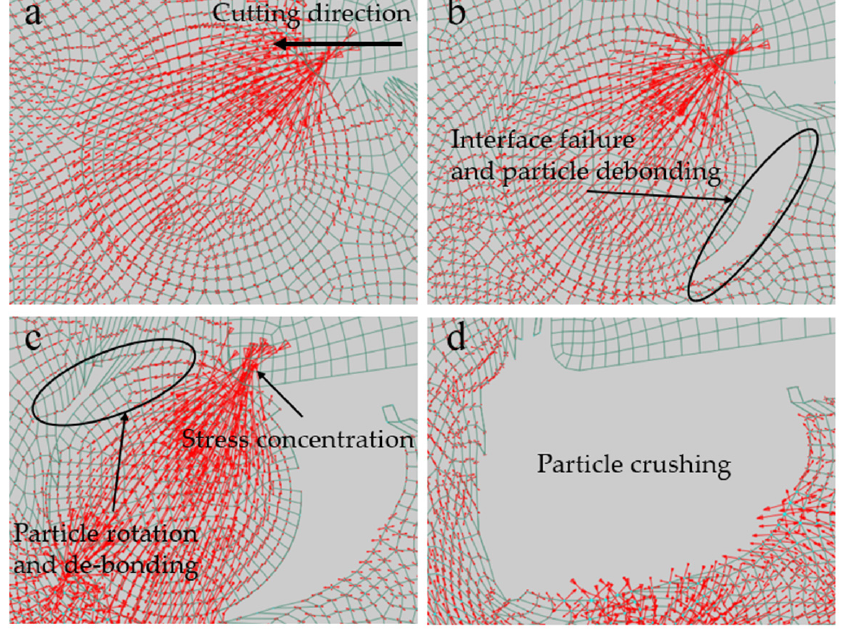
Figure 12. Stress evolution of CCT particle removal process. ( a – d ) is the stress of the particle at different moments during CCT.